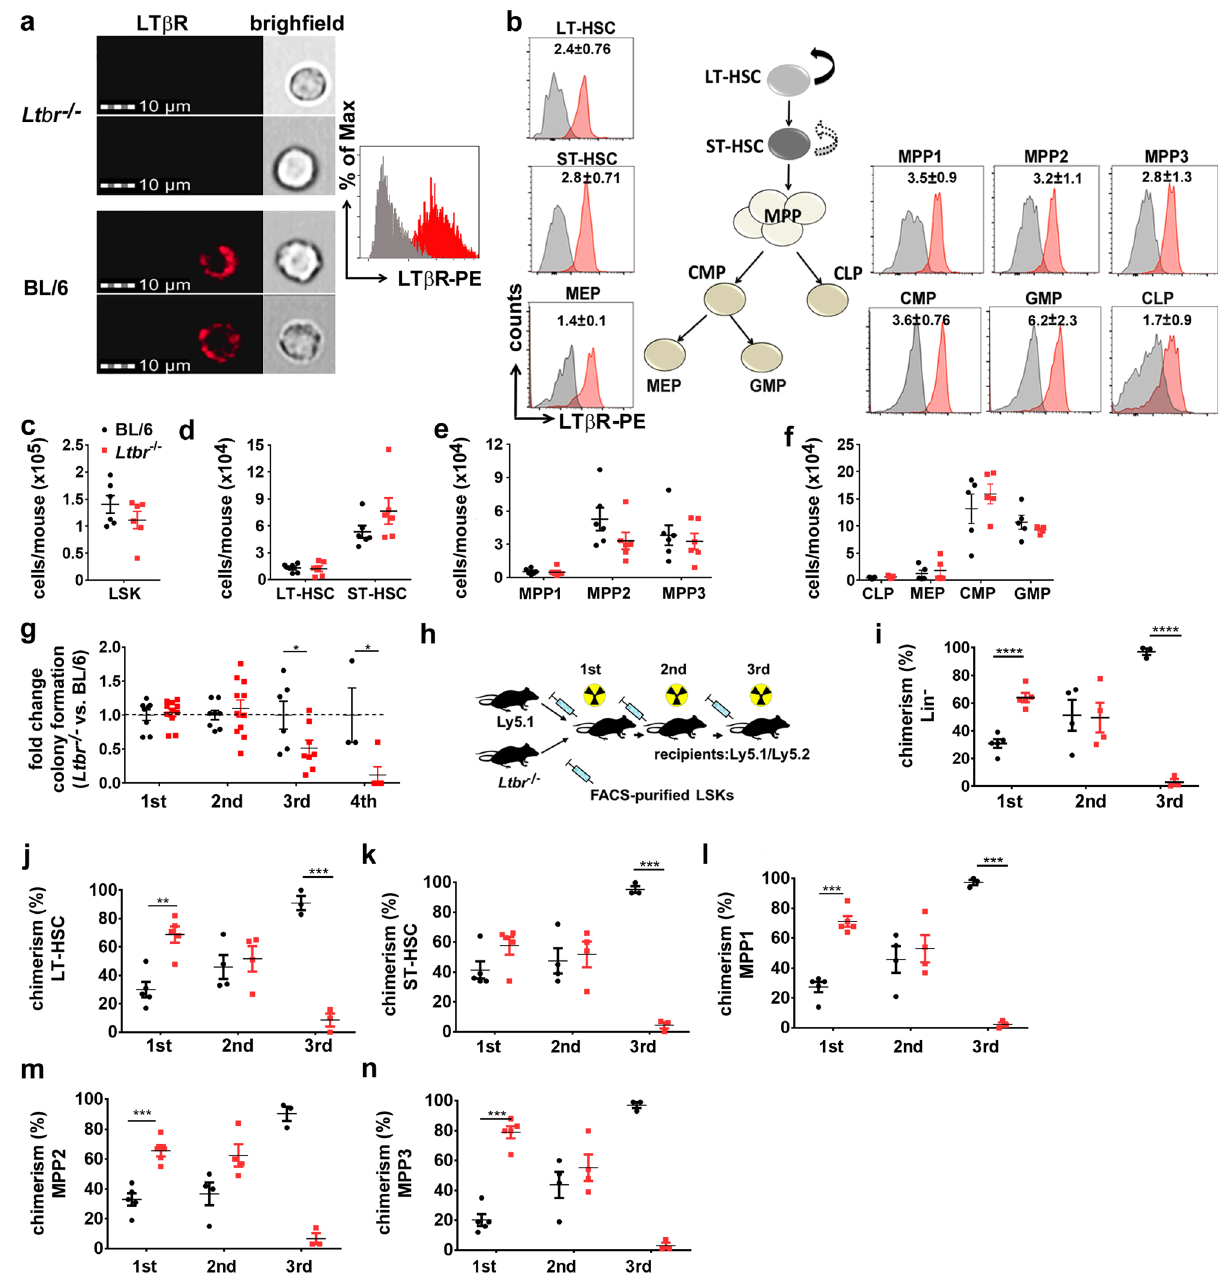
Fig. 1 LT β R expressed by LSKs prevents exhaustion of HSCs. a Left: LT β R expression (red) on BL/6 and Ltbr − / − FACS-puri fi ed BM LSKs analyzed by ImageStreamX MkII. Right: ImageStreamX MkII histogram of LT β R expression on Ltbr − / − LSKs (gray) vs. BL/6 LSKs (red). b Representative FACS histograms of LT β R expression on BM LSK subsets and myeloid progenitor cells. Numbers in plots indicate the ratio MFI stain/isotype ( n = 5 mice). c – f Absolute numbers of LSKs ( c ), LT/ST-HSCs ( d ), MPPs ( e ), CLPs and myeloid progenitors (MEP, CMP, GMP) ( f ) in the BM of naive BL/6 (black, n = 6) and Ltbr − / − (red, n = 6) mice. g Fold change in CFU of Ltbr − / − LSKs relative to BL/6 LSKs in serial re-platings in vitro (1st: n = 8 for BL/6 and 11 for Ltbr − / − ; 2nd: n = 8 for BL/6 and 11 for Ltbr − / − ; 3rd: n = 6 for BL/6 and 8 for Ltbr − / − ; 4th: n = 3 for BL/6 and 5 for Ltbr − / − , one out of two independent experiments). h Schematic of mixed BM chimera and serial re-transplantation. i – n Percentages of Ly5.1 and Ltbr − / − Lin − cells ( i ) and LSK subsets ( j – n